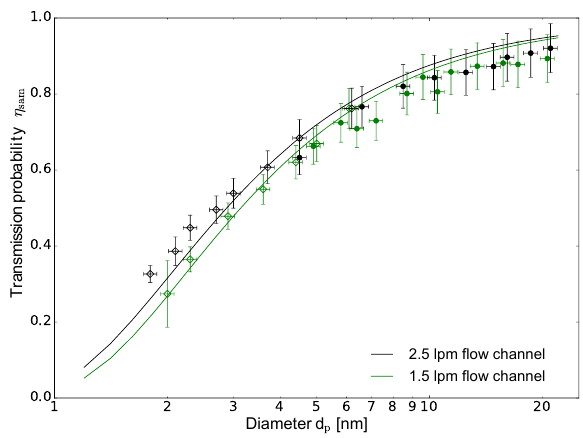
Figure 8. Transmission calibration of the DMA-train. The green points show a measurement for the channels operated with a 1.5Lmin − 1 final sample flow (the CPC channels) and the black points for the channels with a 2.5Lmin − 1 final sample flow (the PSM channels). Open symbols are measured with tungsten ox- ide aerosol particles and filled symbols are measured with silver aerosol particles. The solid lines represent a threefold Gormley and Kennedy equation fit with two free parameters.